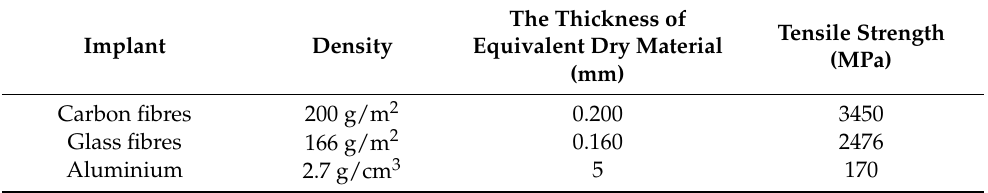
Table 2. Material characteristics of inserted